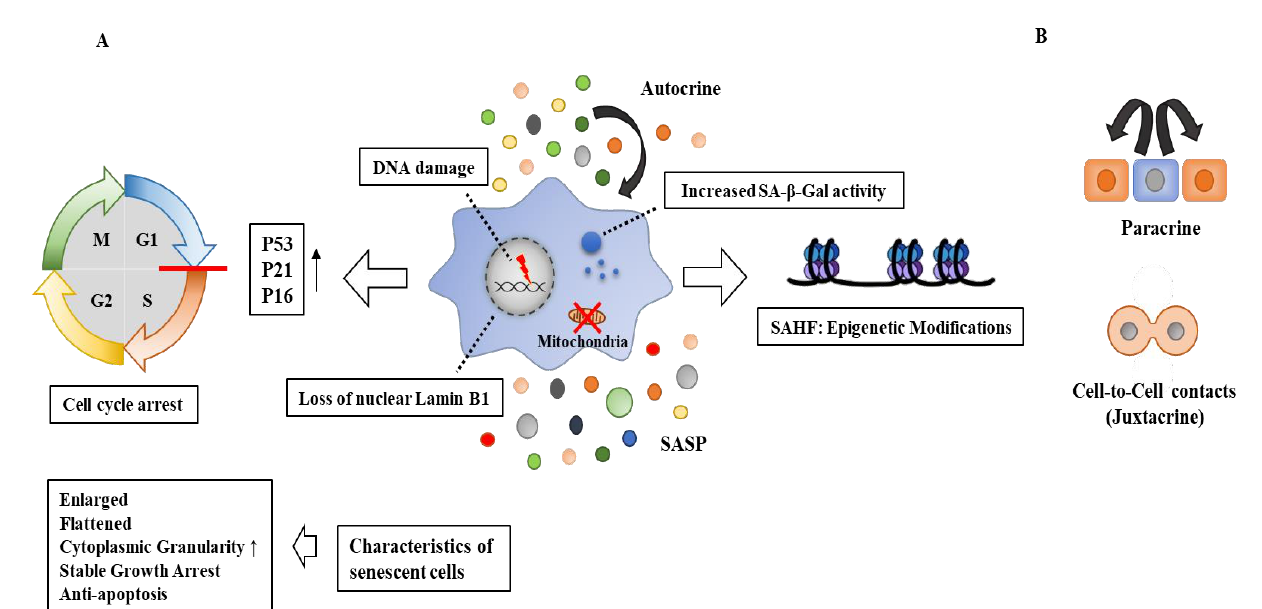
Figure 1. Characteristics of senescence. ( A ) SAHF is senescence-associated heterochromatin foci. Senescence is associated with SAHF in which expression of growth-related genes, such as targets of E2F, is suppressed. SASP refers to the senescence-associated secretory phenotype. Increased SA- β -gal activity leads to increased lysosomal mass. ↑ indicates an increase in expression/activity. The hollow arrows indicate the direction of the reaction. ( B ) Senescence is transmitted in paracrine and juxtacrine fashions. Senescent cells spread senescence via the SASP.